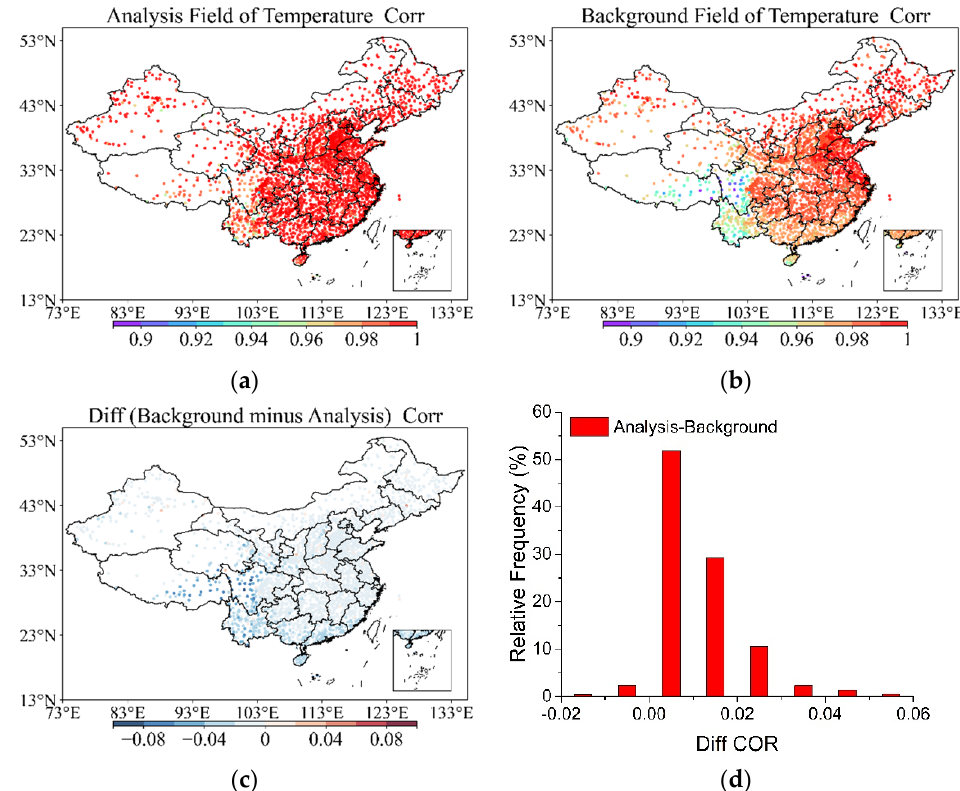
Figure 4. Statistical diagram of COR for temperature based on stations: ( a ) spatial distribution of COR for analysis field; ( b ) spatial distribution of COR for background field; ( c ) spatial distribution of the difference between background field and analysis field for COR; ( d ) frequency distribution of the difference between background field and analysis field for COR.